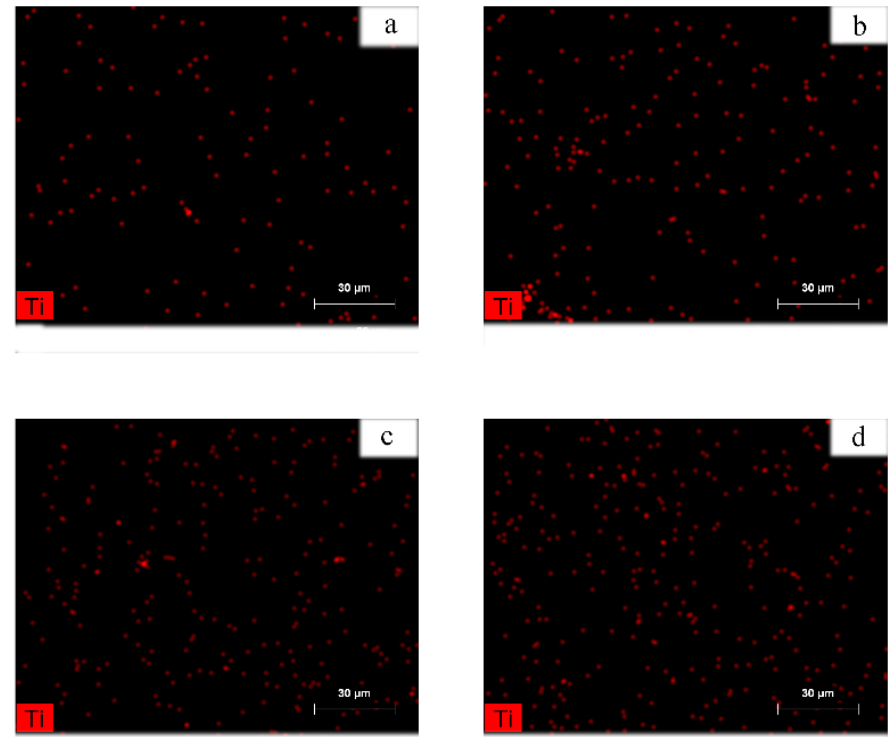
Figure 5. Energy-dispersive X-ray spectroscopy (EDS) mapping of the coPA films containing ( a ) 0.5, ( b ) 1.0, ( c ) 2.5 and ( d ) 5.0 wt. % of MXene.